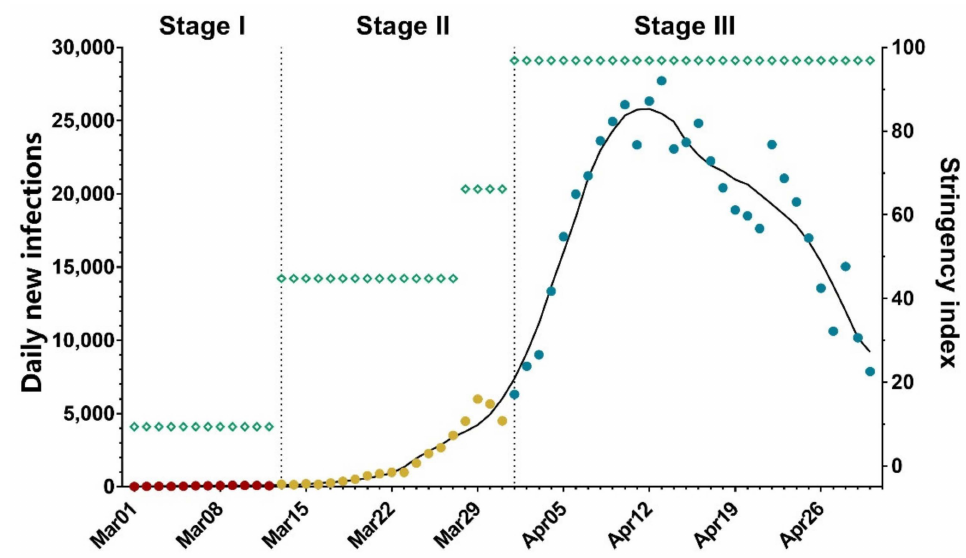
Figure 2. New daily infections in Shanghai with corresponding stringency index. The new daily infections (red, yellow, and blue dots indicate numbers during the Public Health and Social Measures Stage I, II, and III, respectively), with corresponding stringency index (green squares) in Shanghai from 1 March 2022 to 30 April 2022. Dashed vertical lines indicate the beginning date of Stage II and III (March 13th and April 1st, respectively). The raw data were smoothed following a 7-day averaged, 4th-order polynomial method, and the trend was plotted as black curve for daily new